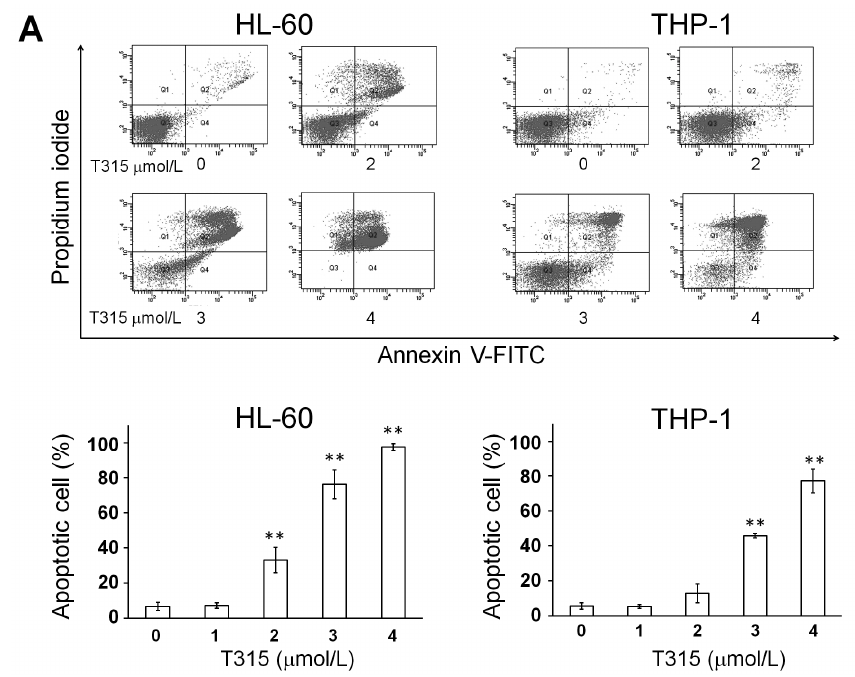
Figure 1. Cont . Figure 1.